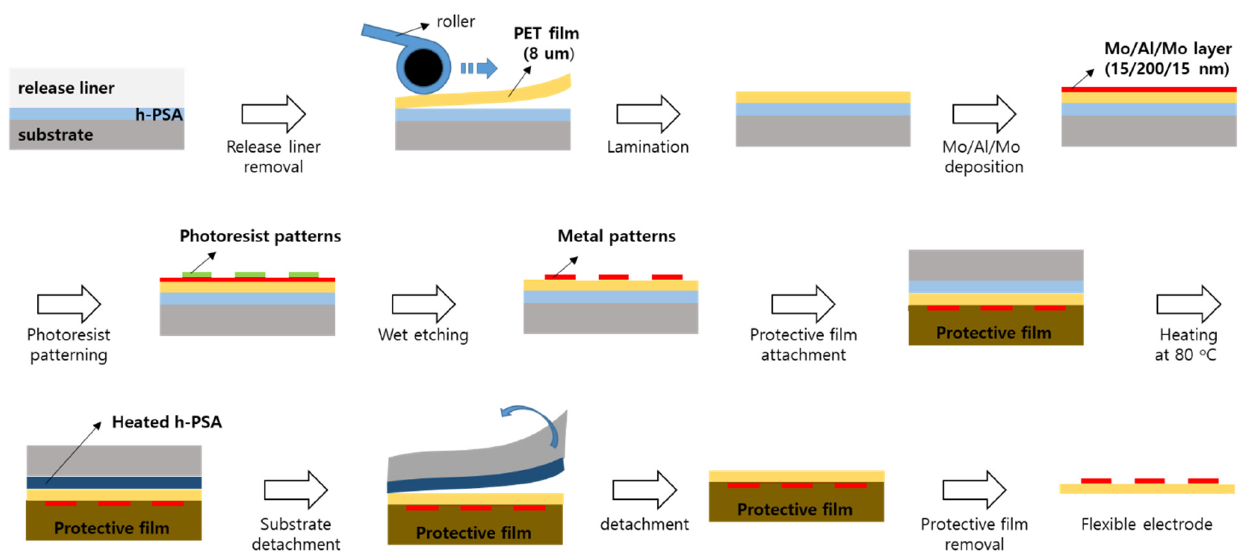
Figure 1. Schematic of the fabrication of the flexible electrode.